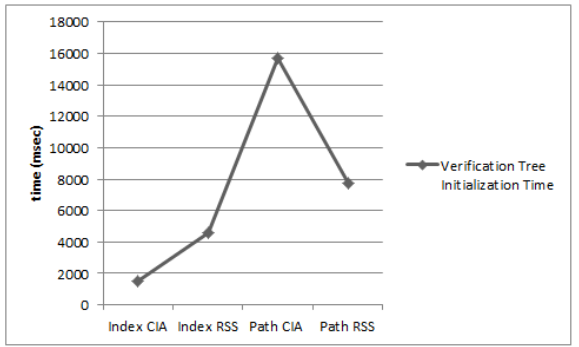
Fig. 5. Xindice Verification Tree Setup